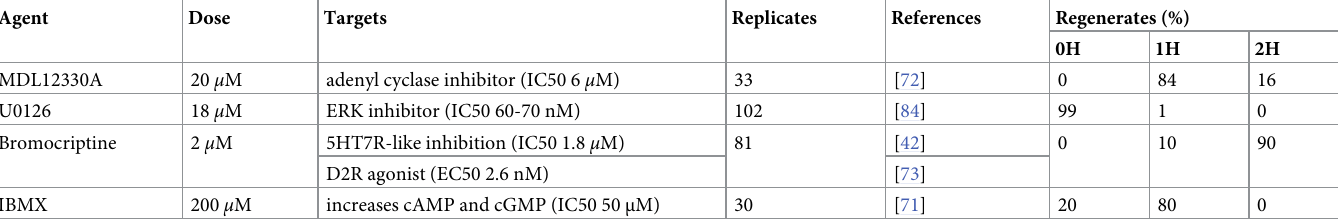
Table 3. Pharmacological agents explored in this work, including their dose, targets, replicates, relevant references, and effects on regenerated planarian morphology.